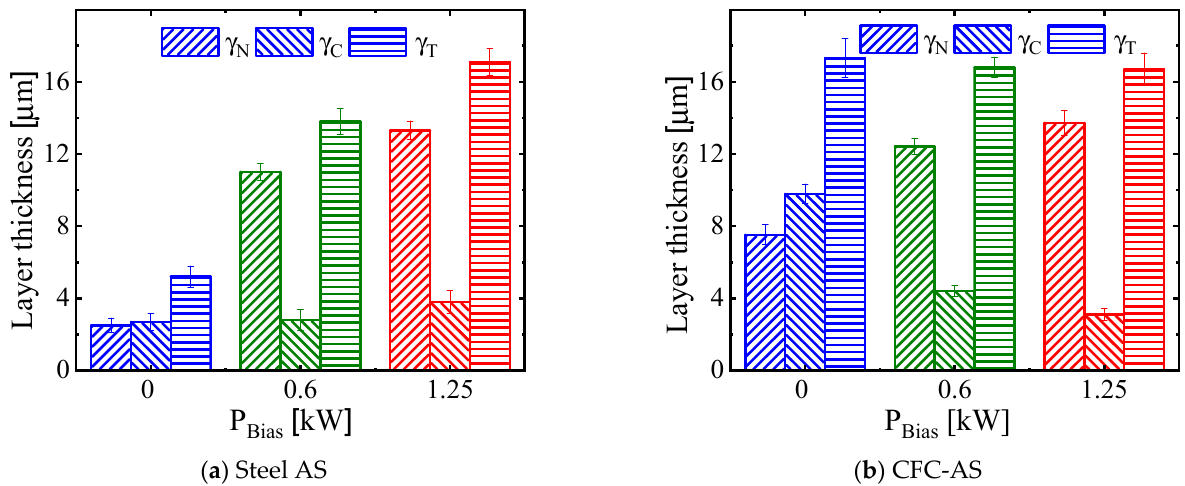
Figure 10. Thicknesses of γ N and γ C layers, as well as the total layer thickness γ T , as a function of bias power for an AS made of steel ( Φ CH4 = 4 slh) ( a ) and of CFC ( b ) determined from cross-sectional optical micrographs of ASPNC-treated samples at H 2 :N 2 = 1:1, p = 3 mbar, T = 460 °C, Φ Total = 80 slh, and t = 5 h.